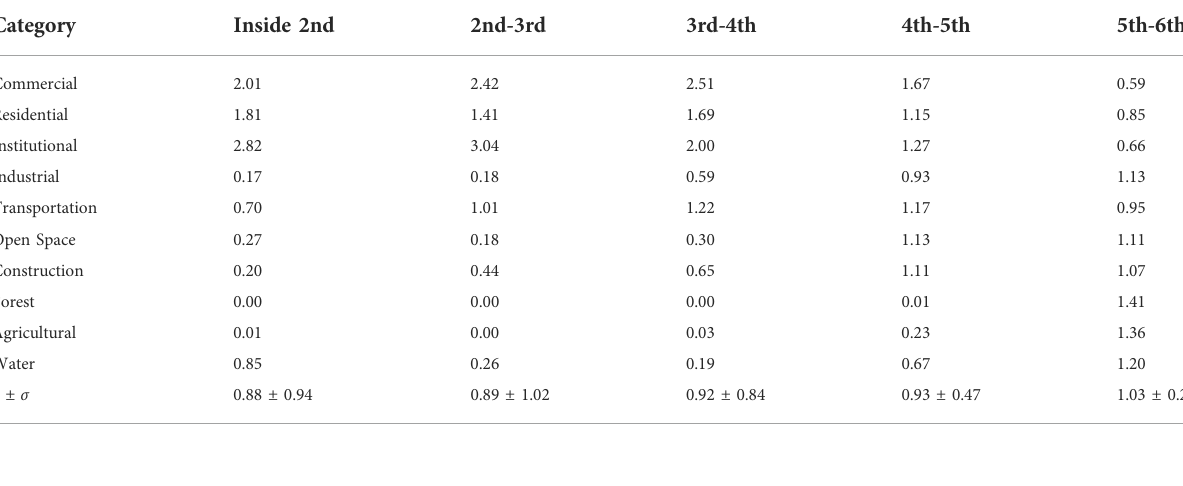
TABLE 3 Location quotient based on the ring